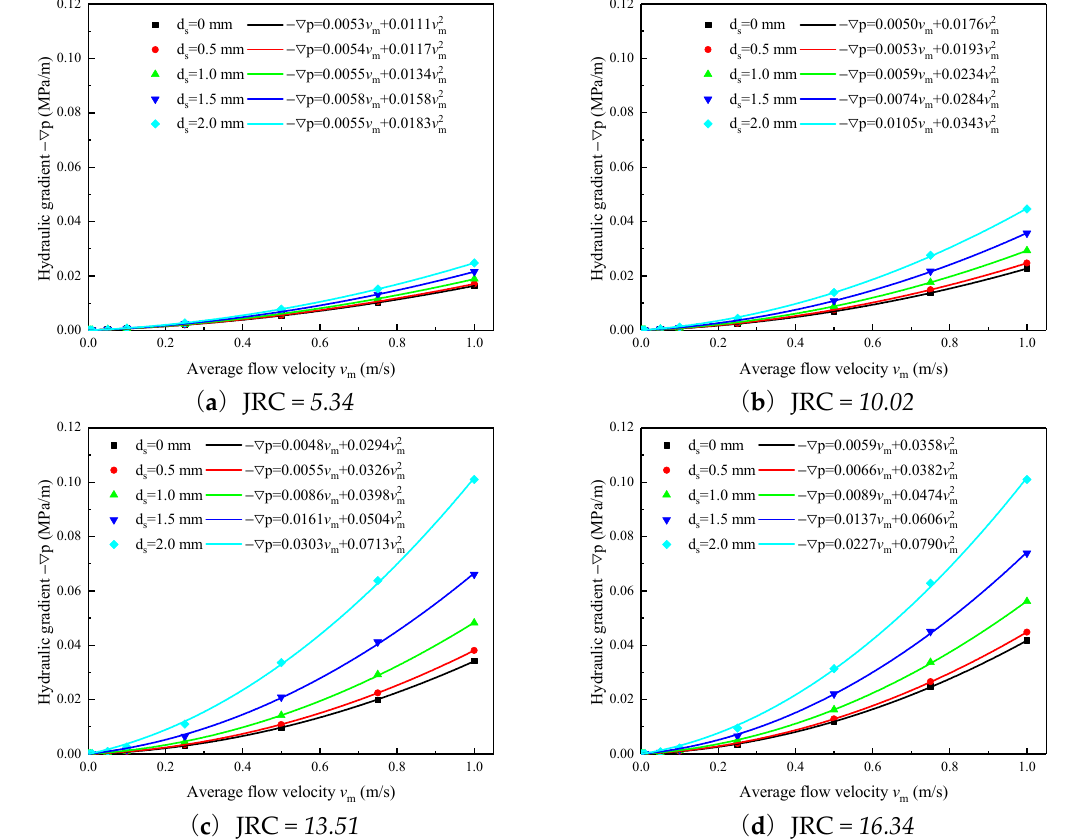
Figure 10. Non-Darcian simulation results and fitting curves using the Forchheimer equation. Water 2020 , 12 , x FOR PEER REVIEW